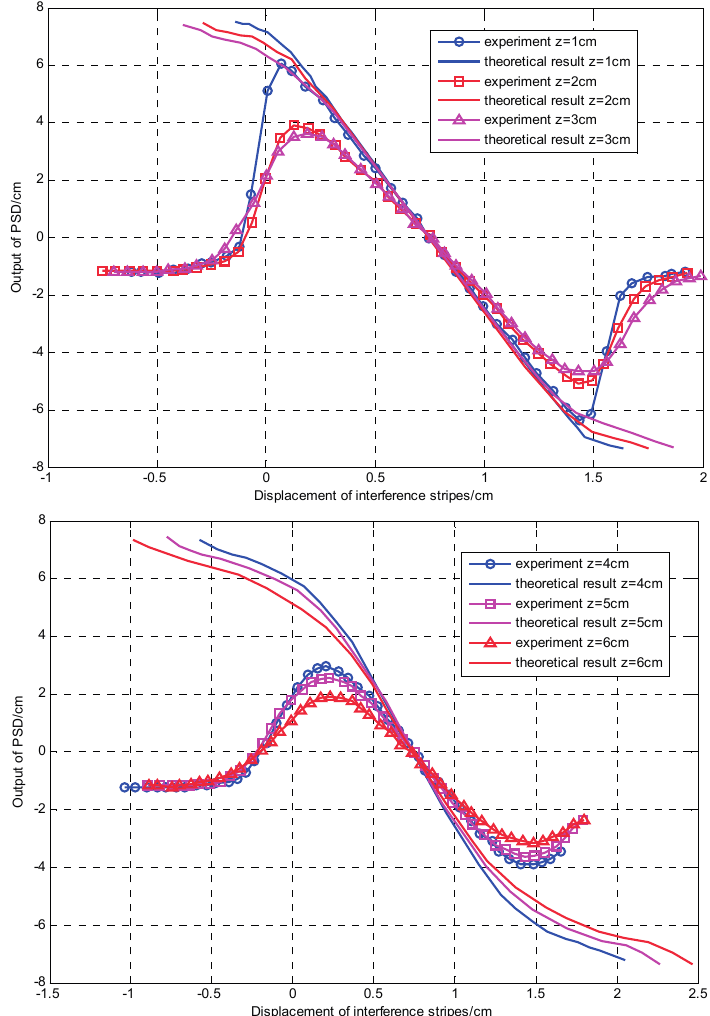
Figure 8. The characteristic curves of the